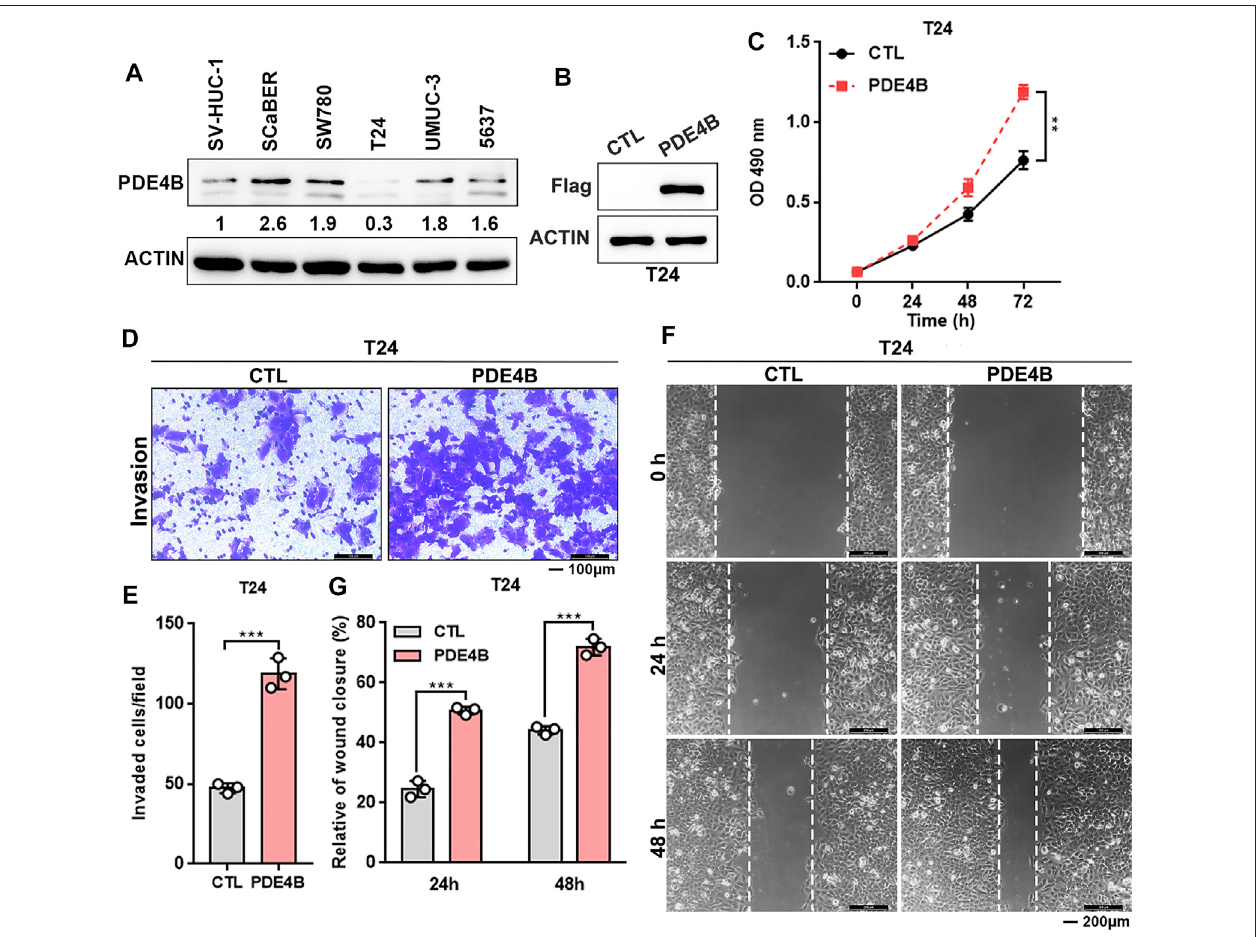
FIGURE 4 | Ectopic PDE4B promotes UBC cells proliferation and invasion. (A) Endogenous expression of PDE4B in multiple cell lines were detected by western blotting. (B) Ectopic expression of PDE4B in T24 cell was con fi rmed by western blotting. (C) Effects of PDE4B overexpression on cell viability. (D – G) Effects of PDE4B overexpression on cell invasion and migration examined by transwell (D,E) and wound healing (F,G) assays. Scale bar, 100 μ m (D) and 200 μ m (F) . ** p < 0.01, *** p < 0.001.